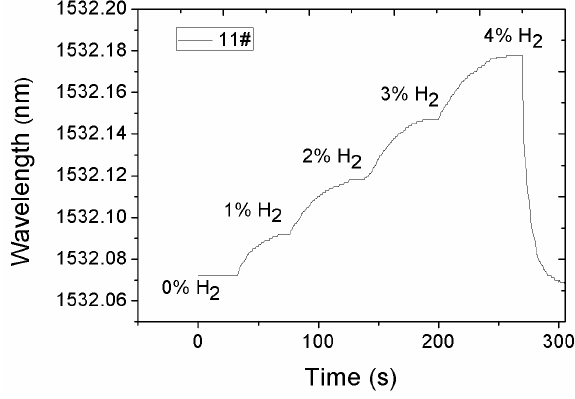
Figure 7. Response curve in different hydrogen concentrations.